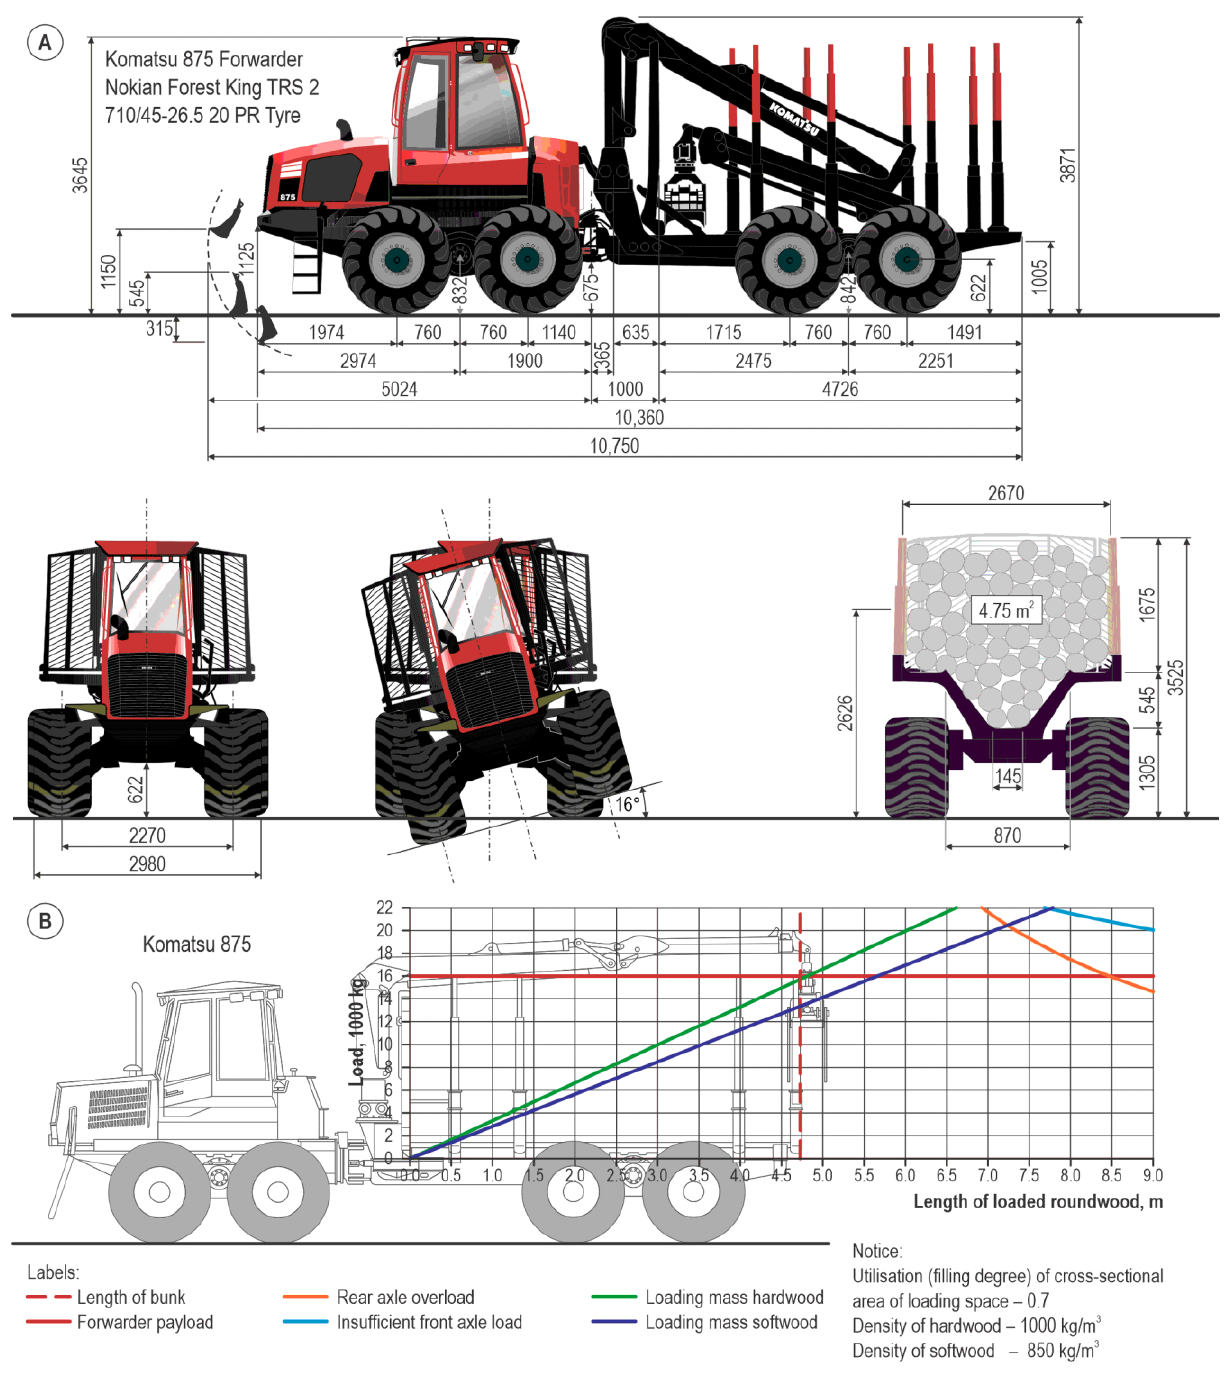
Figure 2. Dimensions ( A ) and load distribution plan ( B ) of Komatsu 875 forwarder [35]. The cross-section of the loading area is 4.75 m 2 , and the length is 4.726 m. Poršinsky et al. [35], showing the dimensional and mass features of the Komatsu 875 forwarder following the ISO 13860 [36] standard, also created a load distribution plan for this forwarder for hardwood (deciduous) and softwood (coniferous) timber according to KWF’s (Kuratorium für Waldarbeit und Forsttechnik) methodology [20–22]. The authors con- cluded that, when the cross-section of the loading area is filled with timber of hardwood 4.82 m long and softwood 5.65 m long, there will be no: (1) exceeding the declared payload by the manufacturer, (2) front and rear axle load capacity overloads, (3) tire overloads, and (4) insufficient front axle